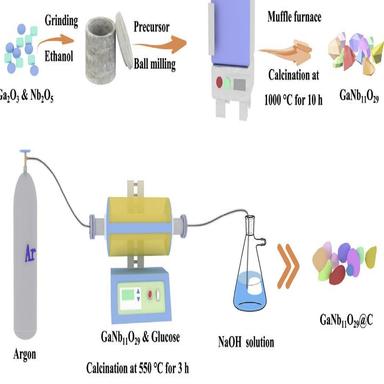
Schematic formation mechanism of GaNb11O29 and GaNb11O29@C.